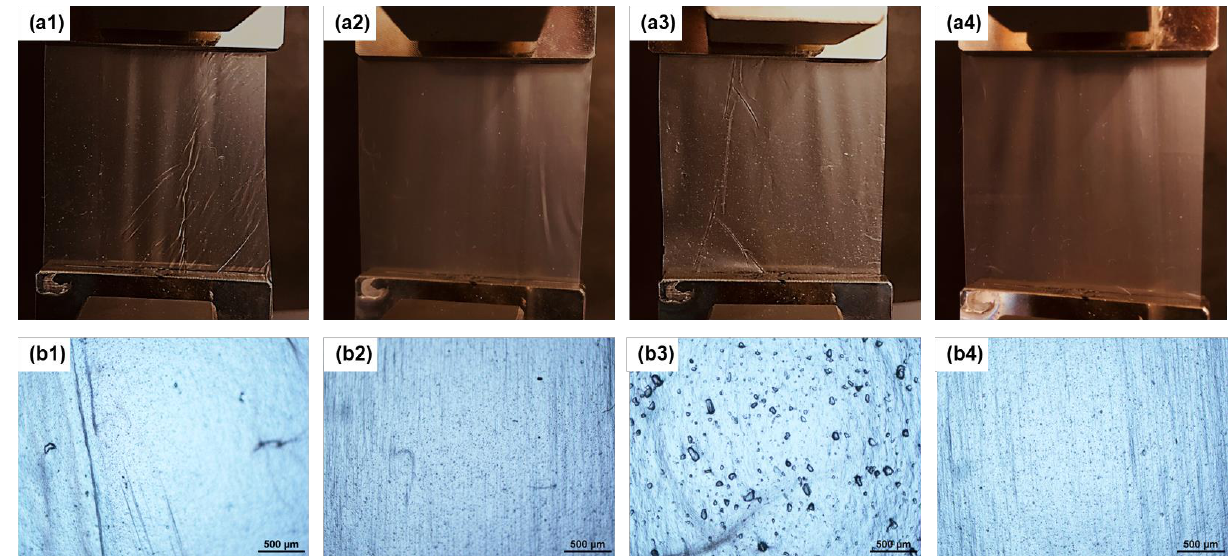
Figure 2. The visual appearance of PLA-PHB, PLA-PHB-OLA, PLA-PHB-OLA-CNC, and PLA- PHB-OLA-ChNC is shown in ( a1 – a4 ), respectively, and optical micrographs of PLA-PHB, PLA-PHB-OLA, PLA-PHB-OLA-CNC, and PLA-PHB-OLA-ChNC are shown in ( b1 – b4 ), respectively (scale bar 500 µm).